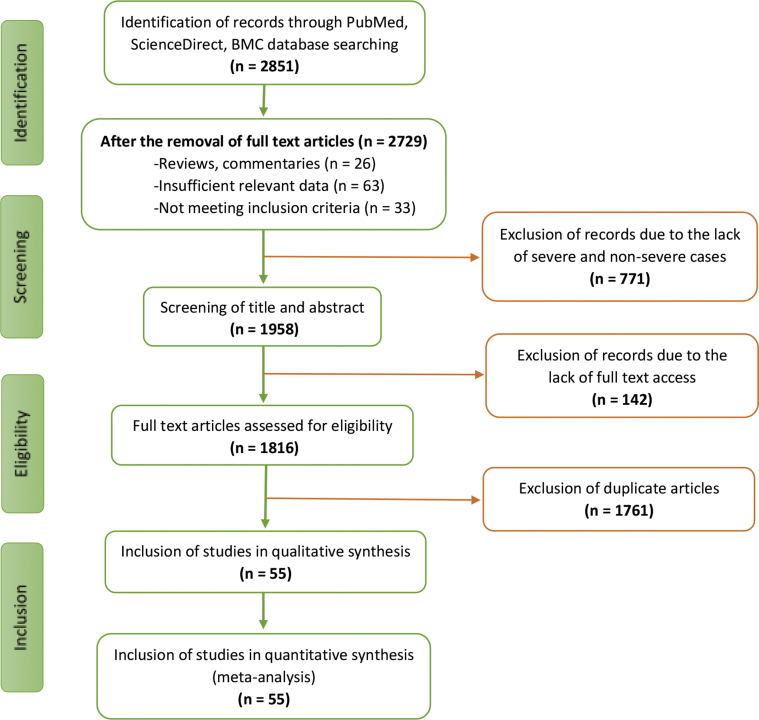
Flow chart illustrating the literature search and study selection.